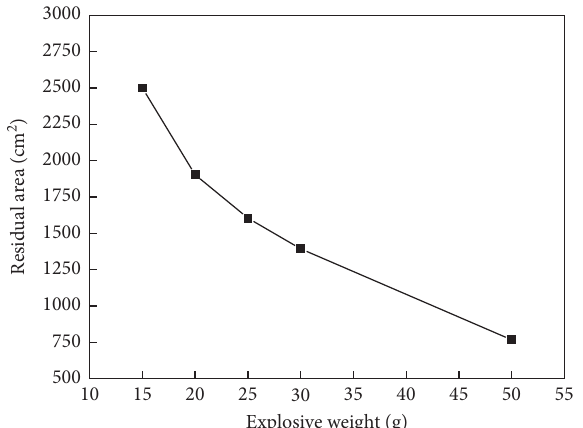
Figure 20: Residual area of polymer slab under close-in